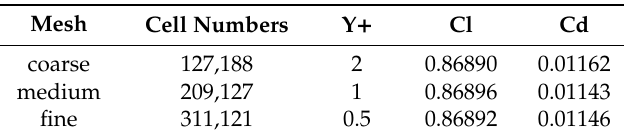
Table 1. Grid independence study.